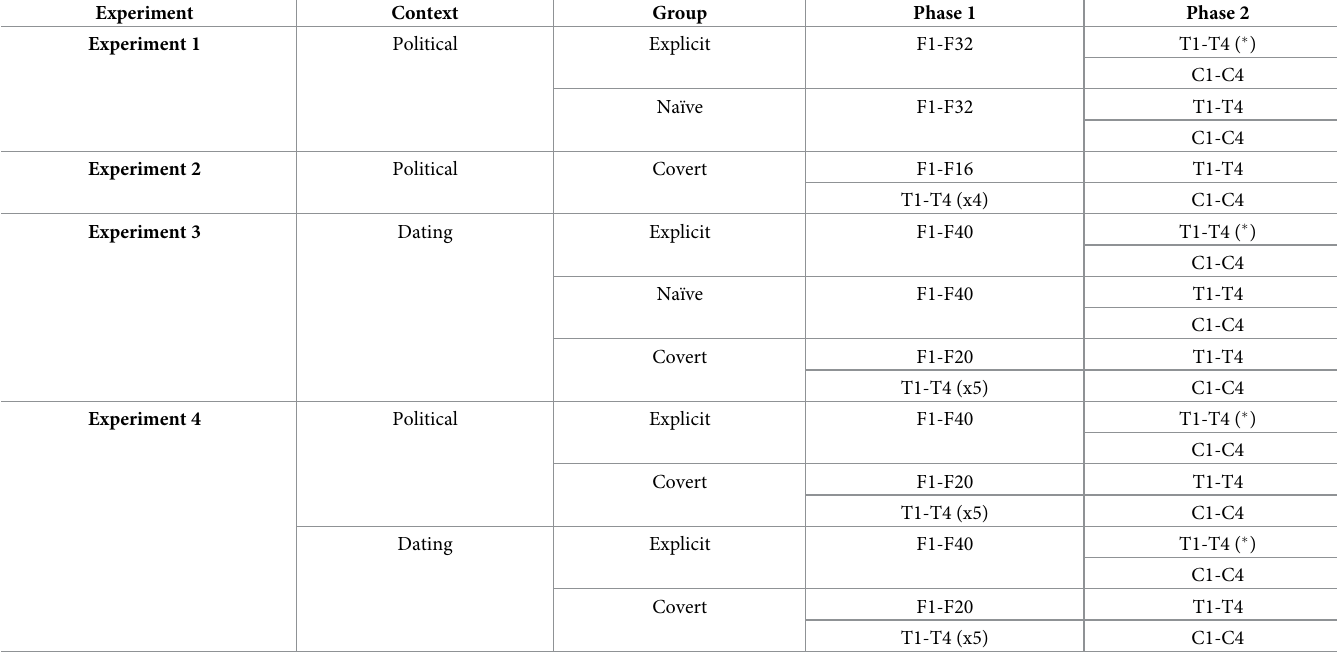
Table 1. Design summary of the